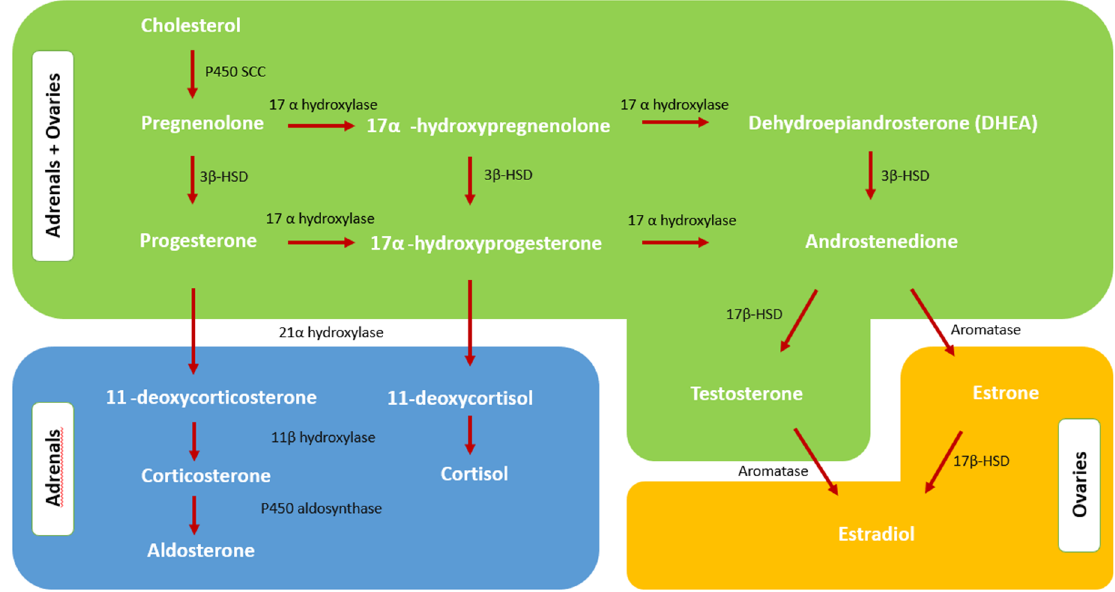
Figure 1. Steroidogenesis pathways in adrenals and ovaries. P450 SCC: side chain cleavage enzyme, 3 β -HSD: 3 β -Hydroxysteroid dehydrogenase, 17 β -HSD: 17 beta hydroxysteroid dehydrogenase.